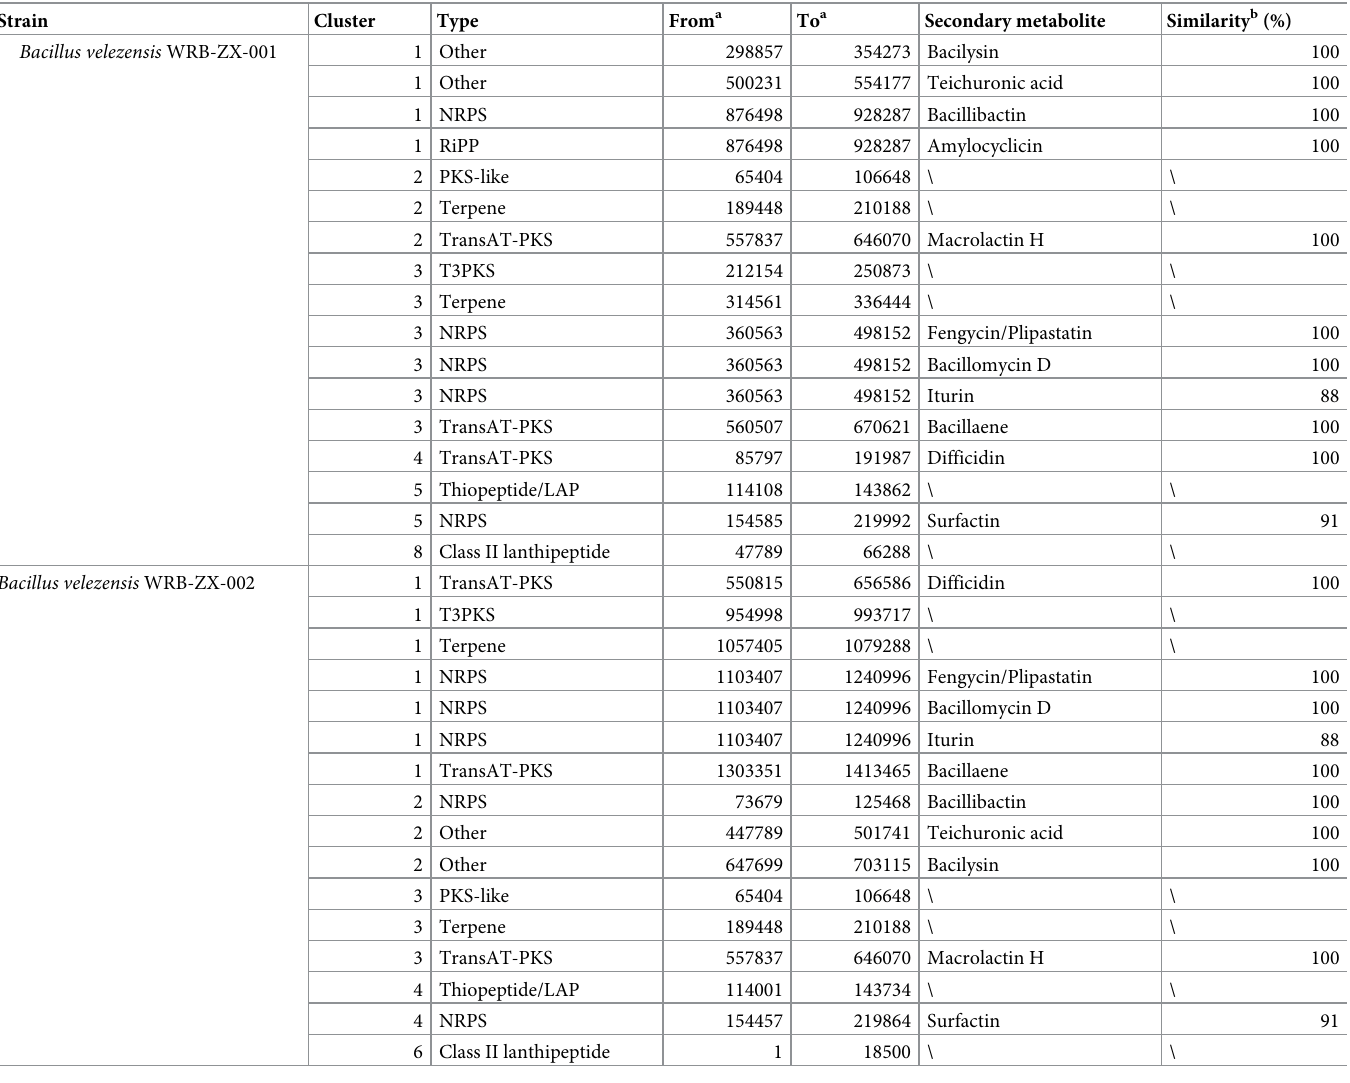
Table 3. Potential secondary metabolite synthesis gene clusters identified in Bacillus velezensis WRB-ZX-001 and WRB-ZX-002 by antiSMASH